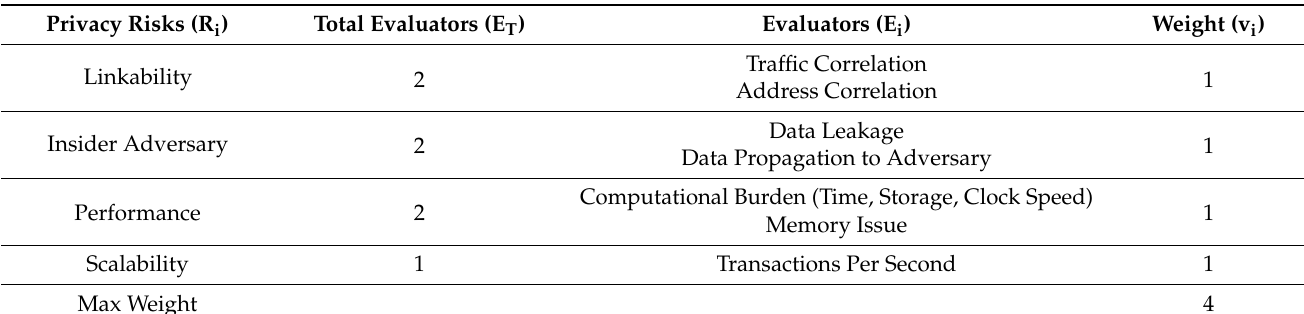
Table 6. Privacy